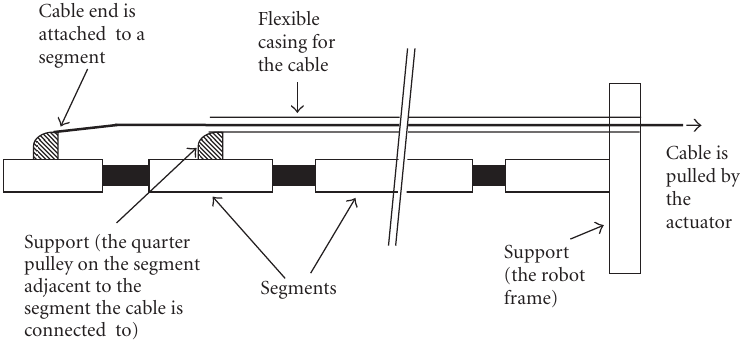
Figure 7: The detail of the cable design—one side only.